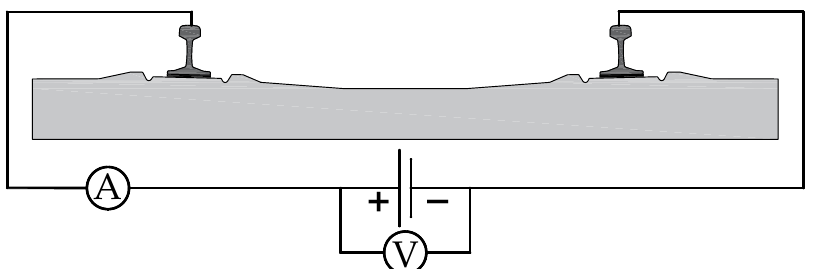
Figure 6. Current circuit for detecting the electrical resistance of the fastening system.